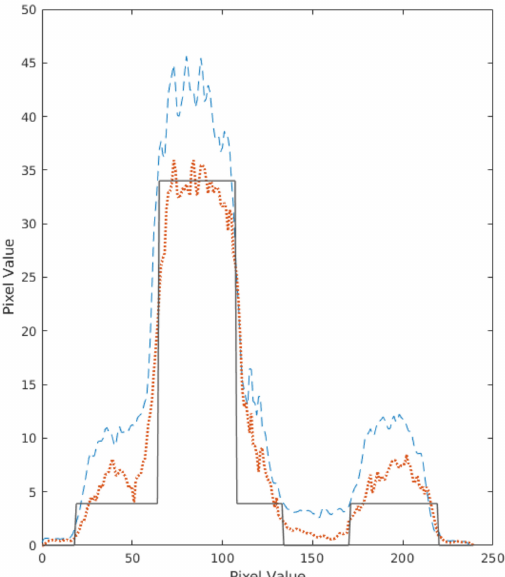
Figure 7. Spatial distribution of counts in a central slice of the reconstructed Utah phantom images, without scatter correction (dashed line), scatter corrected (dots) and generated ground truth using MC simulation (solid line). Vertical pixel value refers to the grey intensity